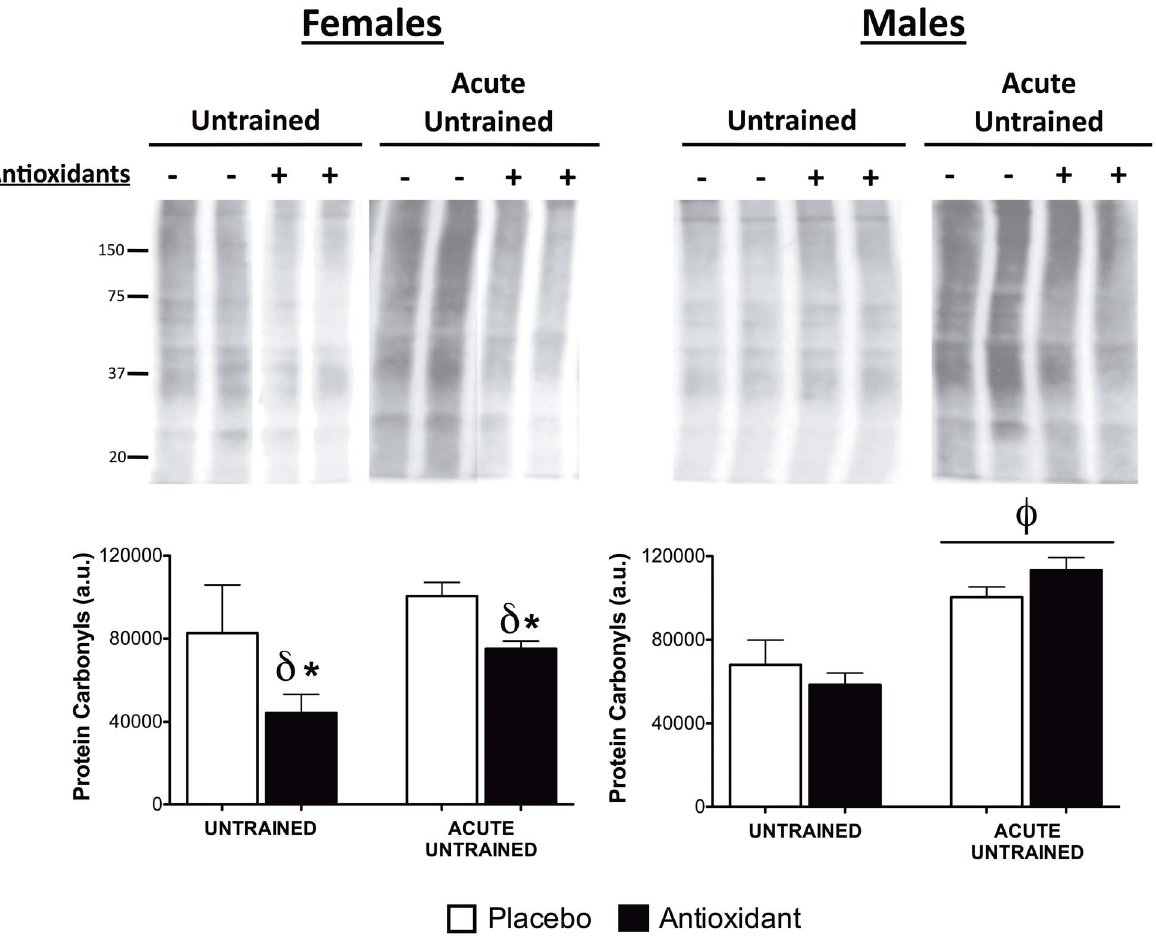
Figure 4. Oxidative damage to proteins. Oxidative damage to proteins was assessed using anti-protein carbonyl antibody, and whole lane staining was quantified as in Figure 3. w indicates a significant (p # 0.05) main effect of exercise, d indicates a significant (p # 0.05) main effect of antioxidant supplementation, and post-hoc testing was used to compare antioxidant- and placebo-supplemented groups, * indicates p # 0.05.